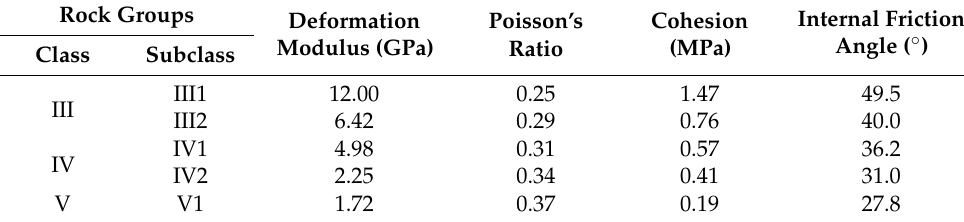
Table 3. Back analysis results of rock parameters for stage II of water impoundment. Rock Groups